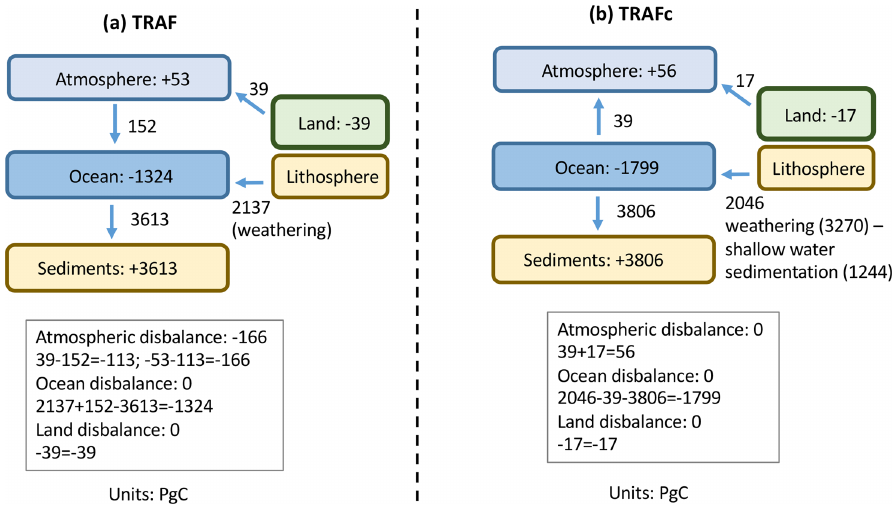
Figure 3. Changes in the carbon cycle compartments (land, ocean, and atmosphere) (PgC), and cumulative fluxes between them (PgC), from 6000BCE to 1850CE in the TRAF (a) and TRAFc (b) simulations. Flux from the lithosphere include weathering (TRAF) and weathering minus shallow-water sedimentation (TRAFc). Carbon budget has a negative 166Pg disbalance in the TRAF simulation, while it is closed in the TRAFc run.